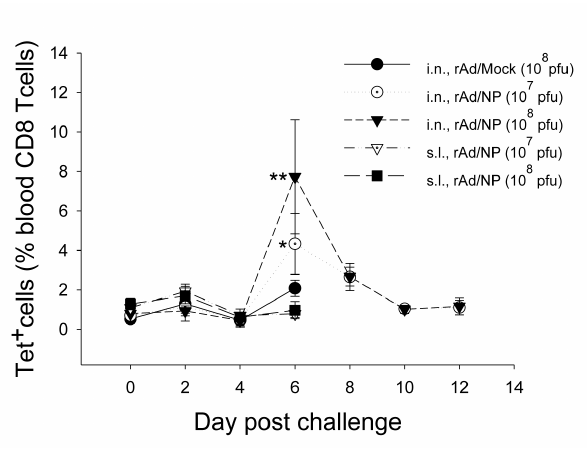
Figure 6. Analysis of NP-specific CD8 T cells in the peripheral blood after rAd/NP immunization and heterosubtypic influenza virus challenge. The BALB/c mice immunized with 1×10 7 or 1×10 8 PFU of rAd/NP were challenged with 10 LD of A/Philippines (H3N2). At each 50 indicated time point after influenza virus challenge, peripheral blood leukocytes from surviving mice of each group were isolated and stained as described in the Materials and Methods. The proportions of NP-specific CD8 T cells were measured by K d /NP tetramer staining and flow cytometric 147-155 analysis. Error bars in the percentages indicate mean ± SEM (n=2~5). Statistical significance with rAd/Mock (*, p=0.03; **,